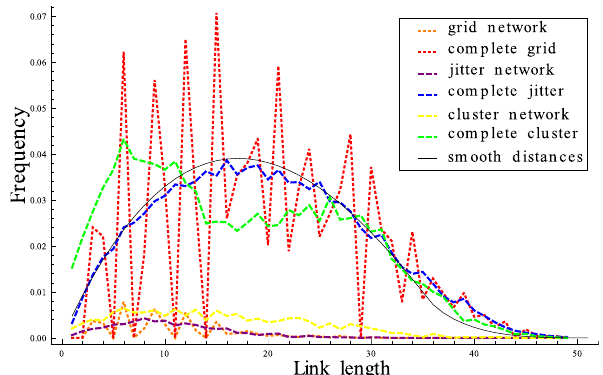
Figure 4. Link length distribution for the three node distributions in